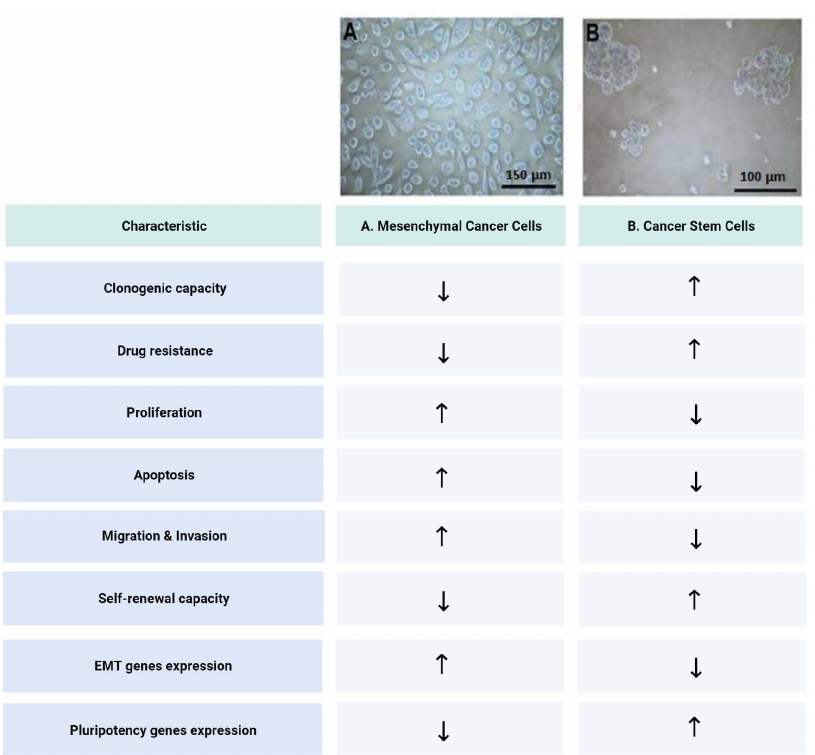
Figure 1. Comparative summary of the main characteristics of mesenchymal cells and cancer stem cell from prostate cancer. ( A ) Mesenchymal cancer cells; ( B ) Cancer stem cells. ↑ : Increased. ↓ : De- creased.